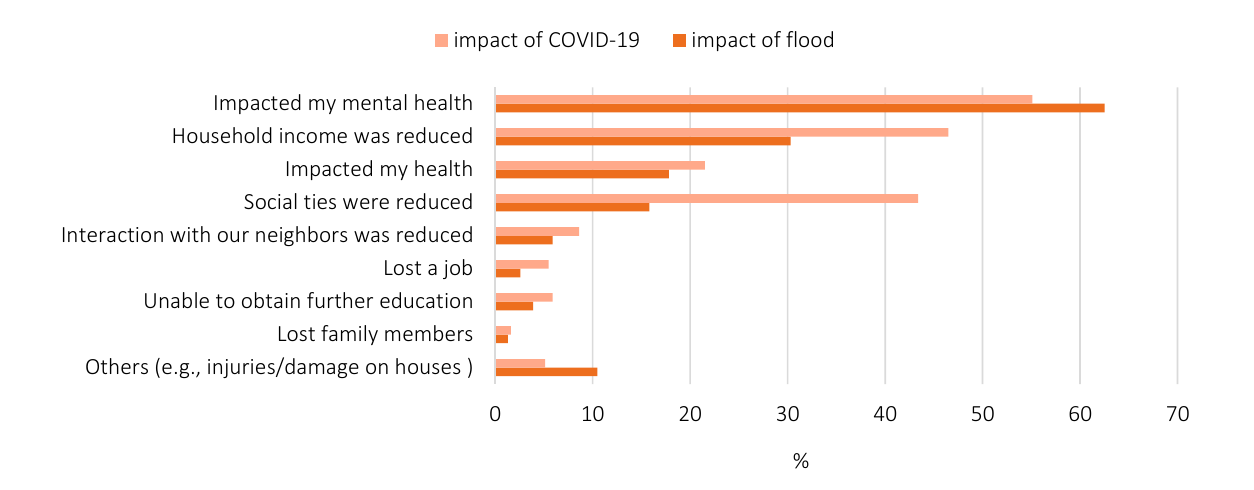
Figure 1. Impacts of COVID-19 and the flood.